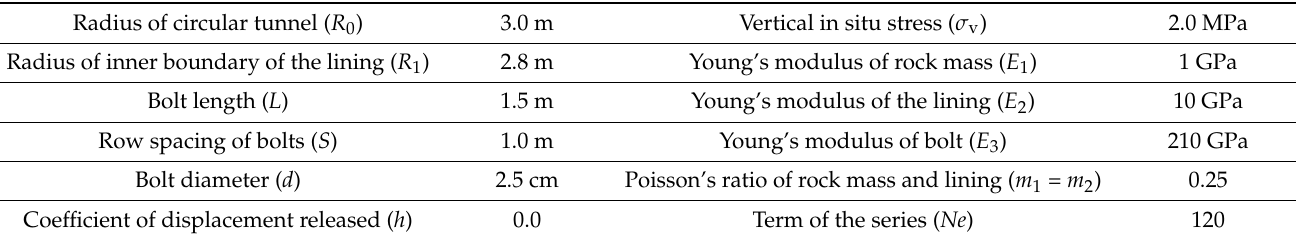
Table 1. The values of relevant